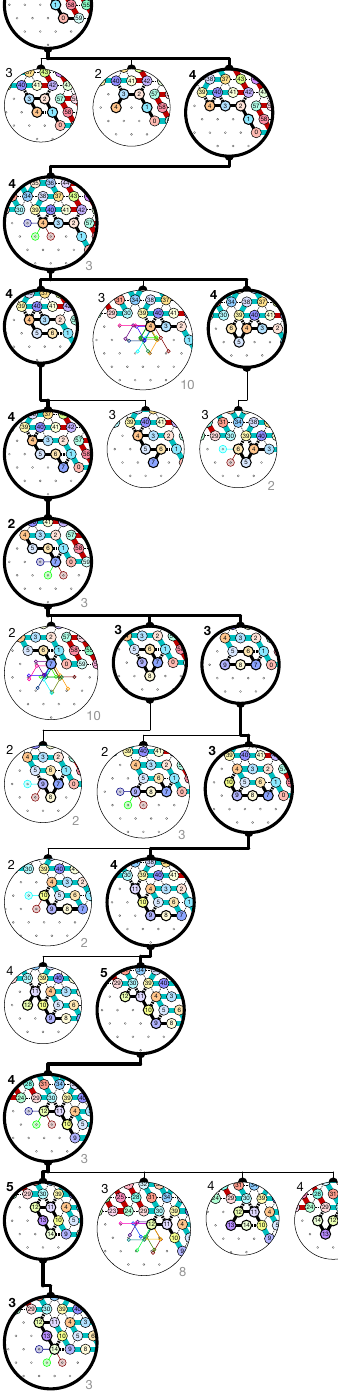
Figure 14. The folding certificate for the brick A01 in the environment: D2B2 C0